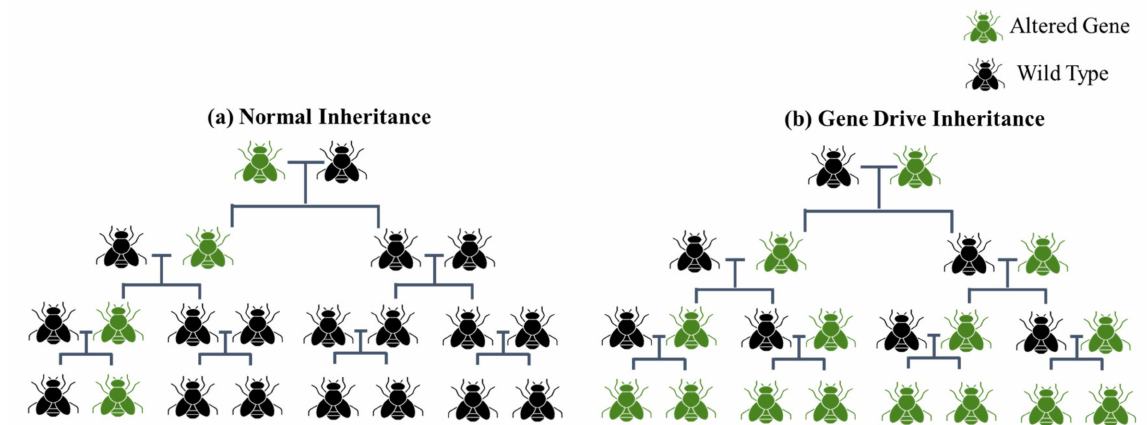
Figure 9. Schematic diagram showing how gene drives linked with CRISPR/Cas systems lead to forced inheritance, spread- ing the relevant trait throughout the whole population: ( a ) normal Mendelian inheritance; ( b ) gene drive-based